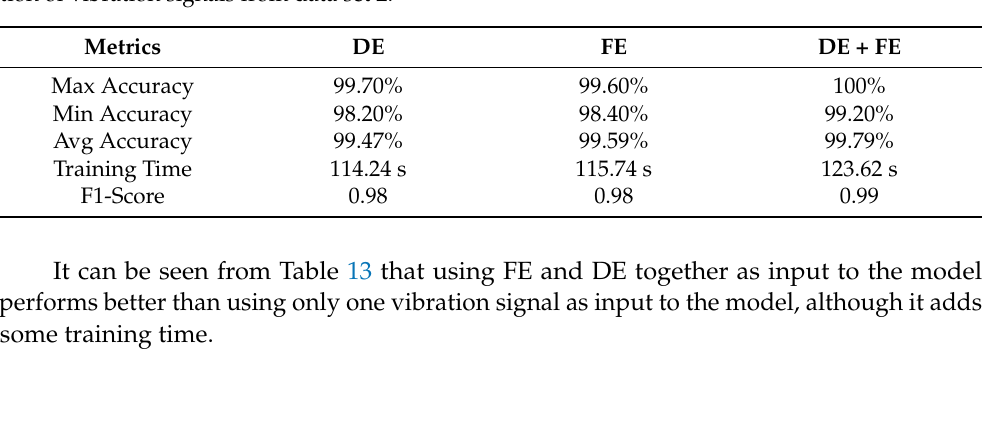
Table 13. Performance of the proposed model tested by the data sets formed using different combina- tion of vibration signals from data set